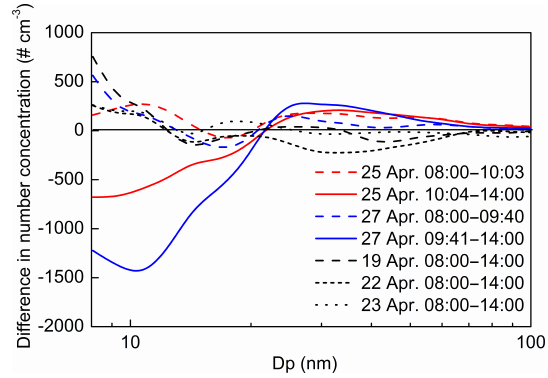
Figure 4. The size-dependent difference in number concentrations (calculated as the PNC of different-sized particles at the street site minus the corresponding value at the rooftop site) during various periods in April 2012 (solid and dash lines represent the results dur- ing NPF and non-NPF periods,